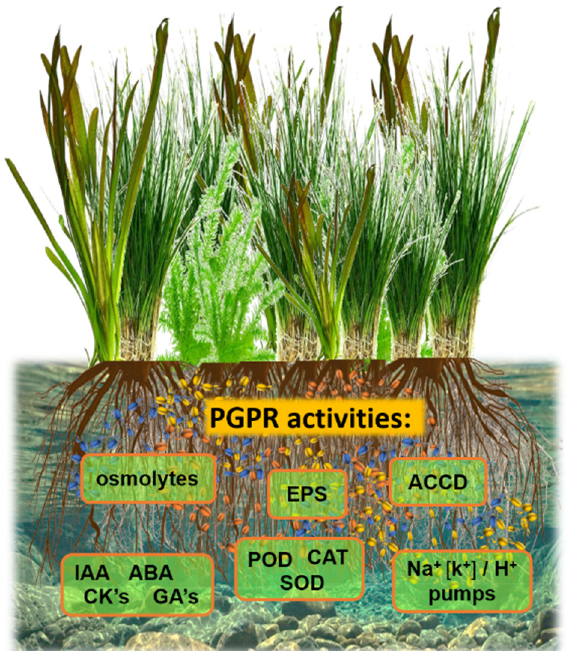
Figure 3. Scheme of a constructed wetland (CW) for a phytodepuration approach. The most critical PGPR activities beneficial to support and to alleviate environmental stresses (salinity, heavy metals, hydrocarbons) are the production of phytohormones, 3-indol acetic acid ( IAA ), abscisic acid ( ABA ), cytokines ( CK’s ), gibberellins ( GA’s ) modulating plant physiology; ACC deaminase ( ACCD ) activity lowering ethylene level; activation of antioxidant enzymes (superoxide dismutase, SOD ; catalase, CAT ; peroxidase, POD ); Na + (K + )/H + pumps regulating ions homeostasis; production of exopolysaccharides ( EPS ); production of osmolytes (i.e., proline, glycine, betaine) to stabilize protein conformation.